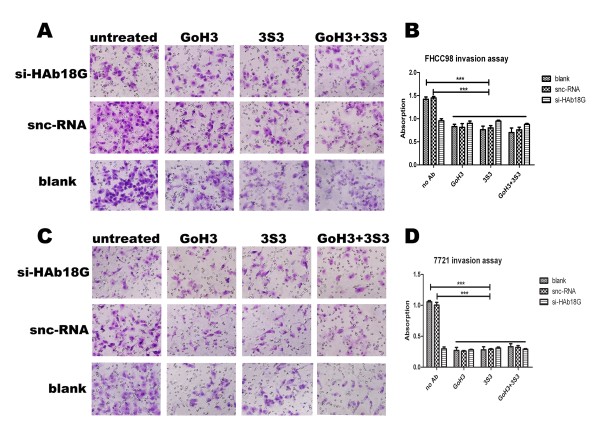
Invasion of hepatoma cells with or without integrin α6β1 mAbs and siHAb18G/CD147 treatment. (A-D) Matrigel invasion assay of FHCC98 (A, B) and 7721 (C, D) cells. Bars represent the mean of triplicate samples; error bars represent standard deviation. Data are representative of three independent experiments. ***P < 0.01 versus corresponding cells with no antibody treatment.